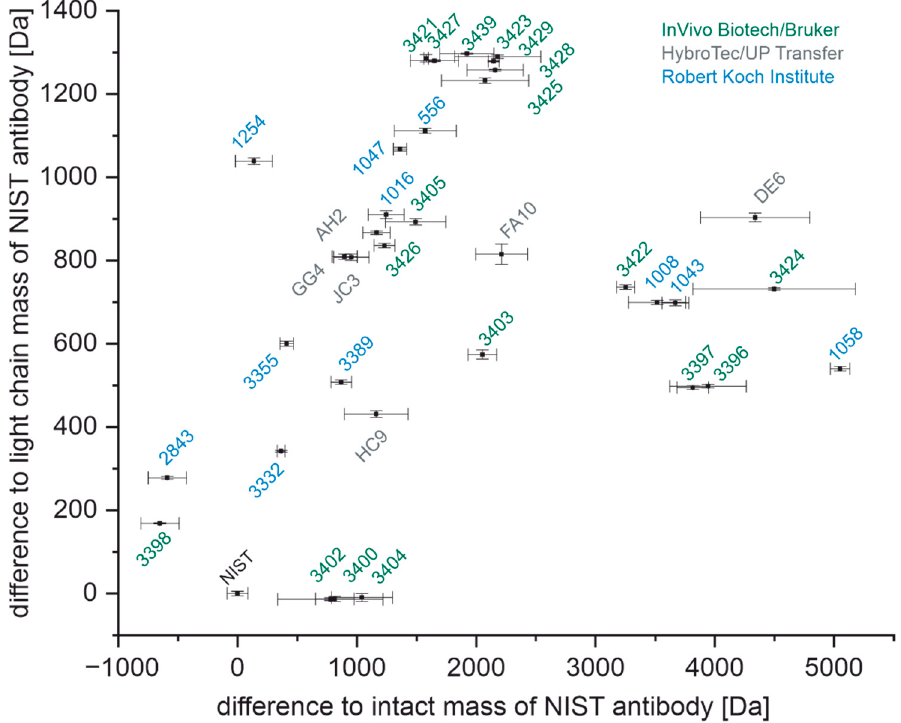
Figure 5. Light chain and intact masses of all antibodies relative to the NIST antibody, including their respective confidence intervals. The remaining non-unique antibodies are shown in Figure S1. Antibodies raised from immunization by InVivo Biotech/Bruker are colored in green, antibodies raised from immunization by HybroTec/UP Transfer are colored in grey, and antibodies raised by the Robert Koch Institute are colored in blue.